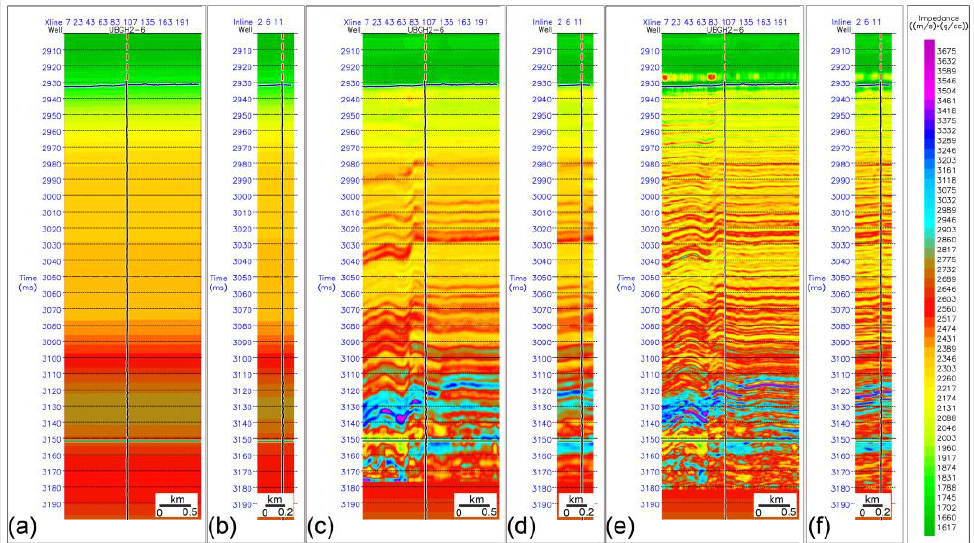
Figure 7. Inline 13 and crossline 102 crossing the UBGH2-6 well. ( a ), ( b ) Initial model for the C3DS seismic inversion, and inversion result for ( c ), ( d ) C3DS and ( e ), ( f ) H3DS. Black lines inserted in each figure show the acoustic impedance log of the UBGH2-6 well.